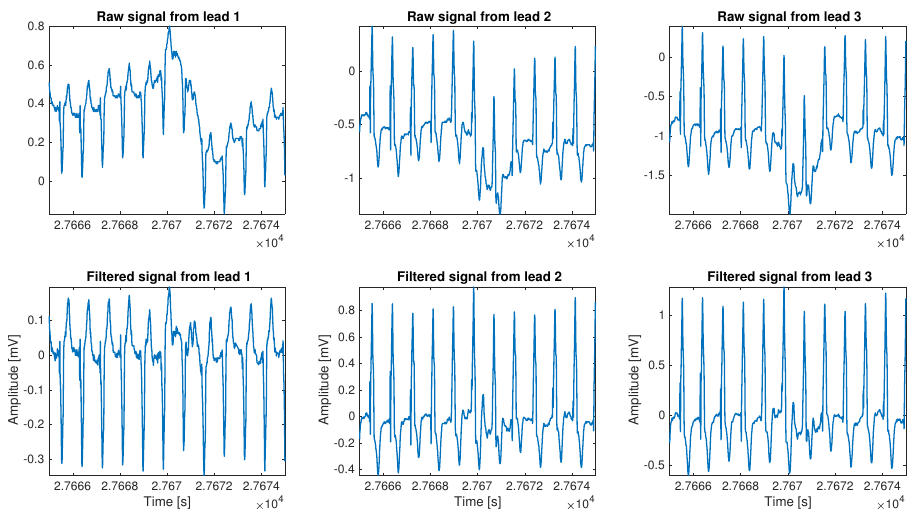
Figure 2. Example of the signal preprocessing stage over a segment of 3-lead signal from vPREDICT